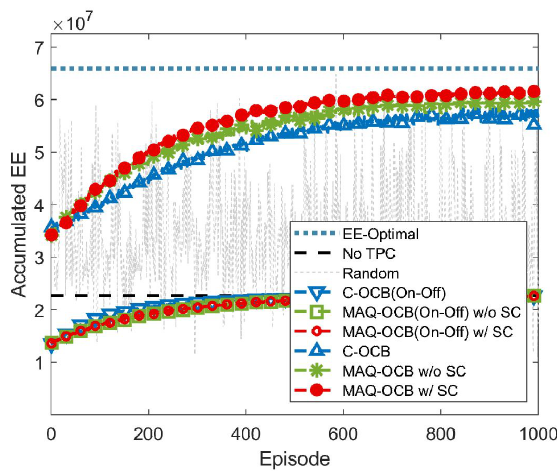
Figure 4. Energy efficiency vs. episode when | U | = 60, | M | = 3, and | N | = 6.